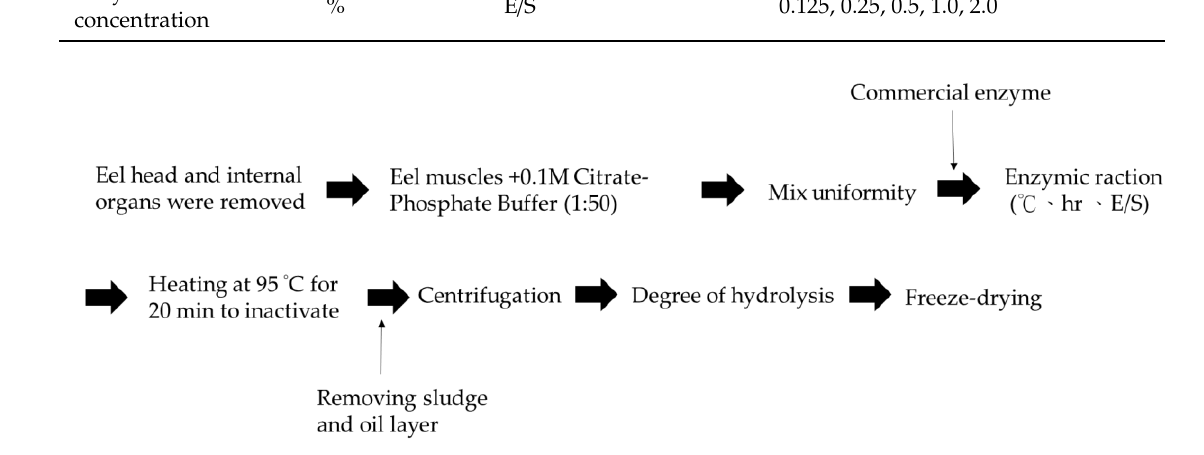
Figure 4. Scheme of the hydrolysis process of Anguilla marmorata . 256